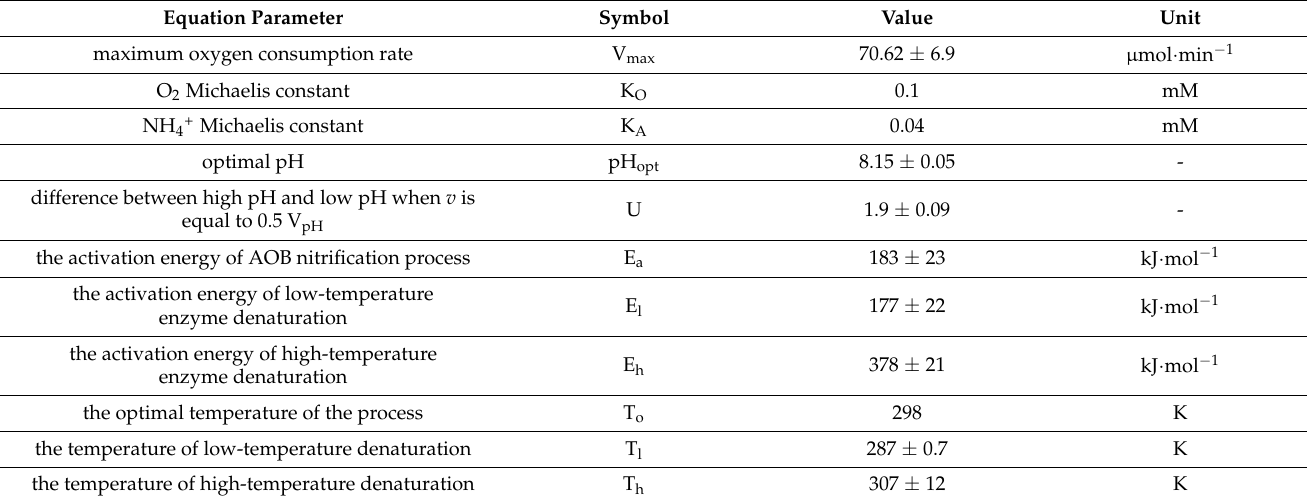
Table 1. Parameters of the ABTOW